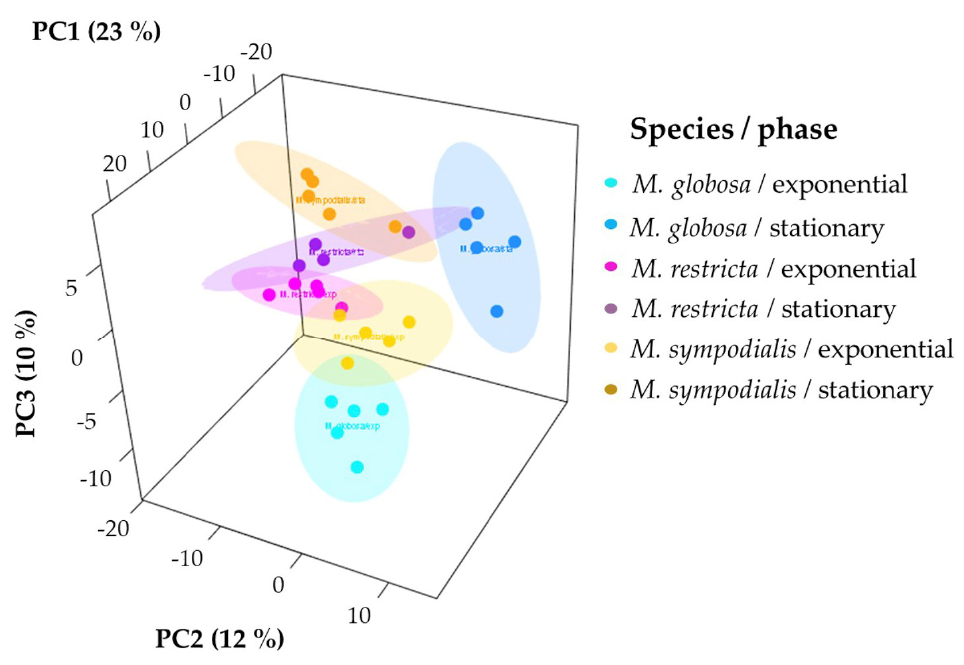
Figure 4. Principal component analysis (PCA) of the volatile profiles of Malassezia species in the exponential and stationary growth phases. The ellipses in this plot are confidence intervals of 95% using a normal distribution.